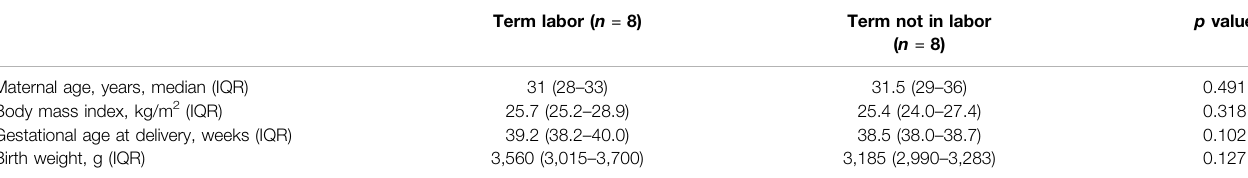
TABLE 1 | Demographic and clinical characteristics of recruited pregnant